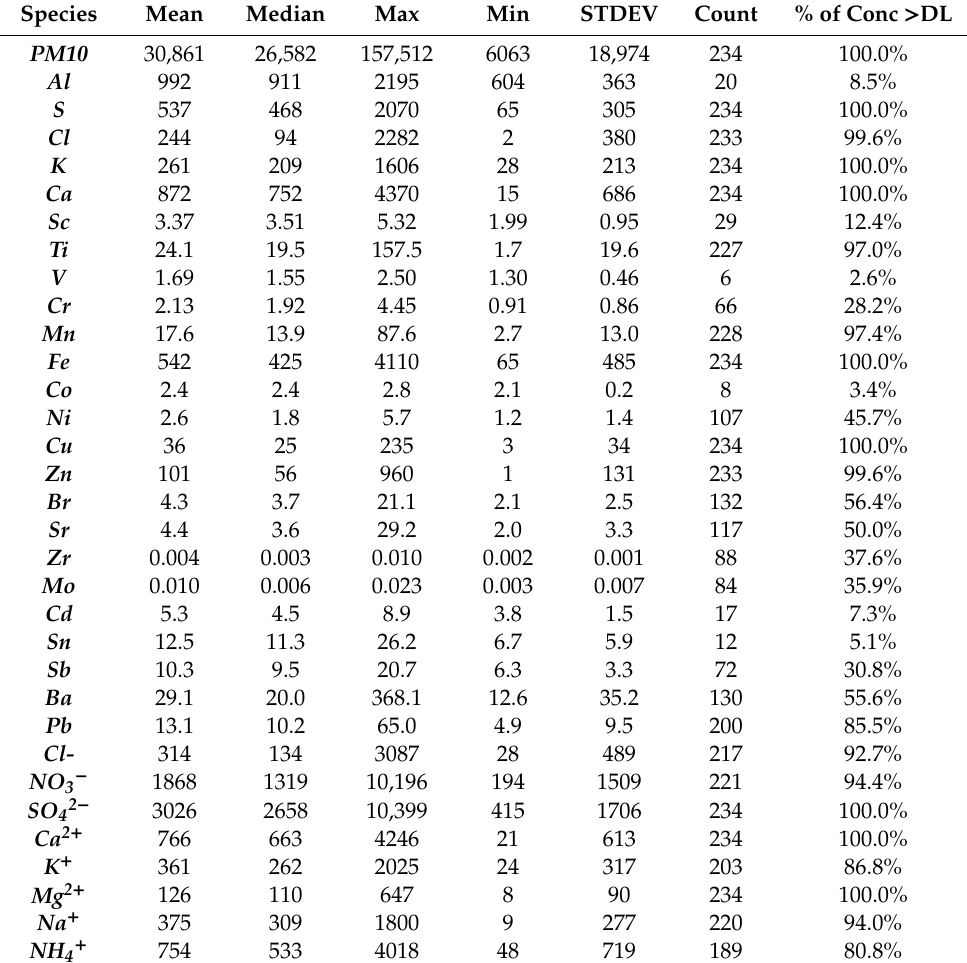
Table 1. Statistical results for the measured PM10 and element concentrations in ng m −